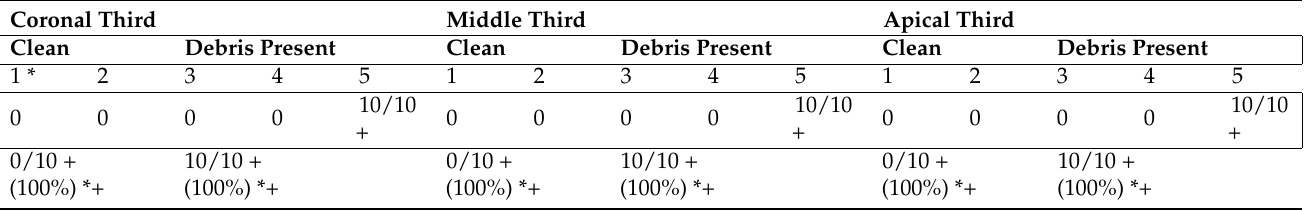
Table 15. Group 2: Debris score with